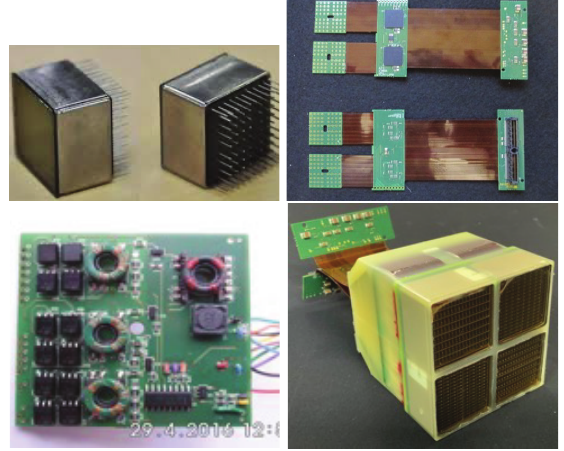
Figure 3. JEM-EUSO FT detection unit. Top left: 64 pixel MAPMTs used by all JEM-EUSO missions. Top right: ASIC boards using SPACIROC 3. Middle left: Cockroft-Walton (CW) high-voltage power supply. Middle right: 4 MAPMTs, 2 ASIC boards and 1 CW board assembled into a potted elementary cell of the third generation for the EUSO-SPB2